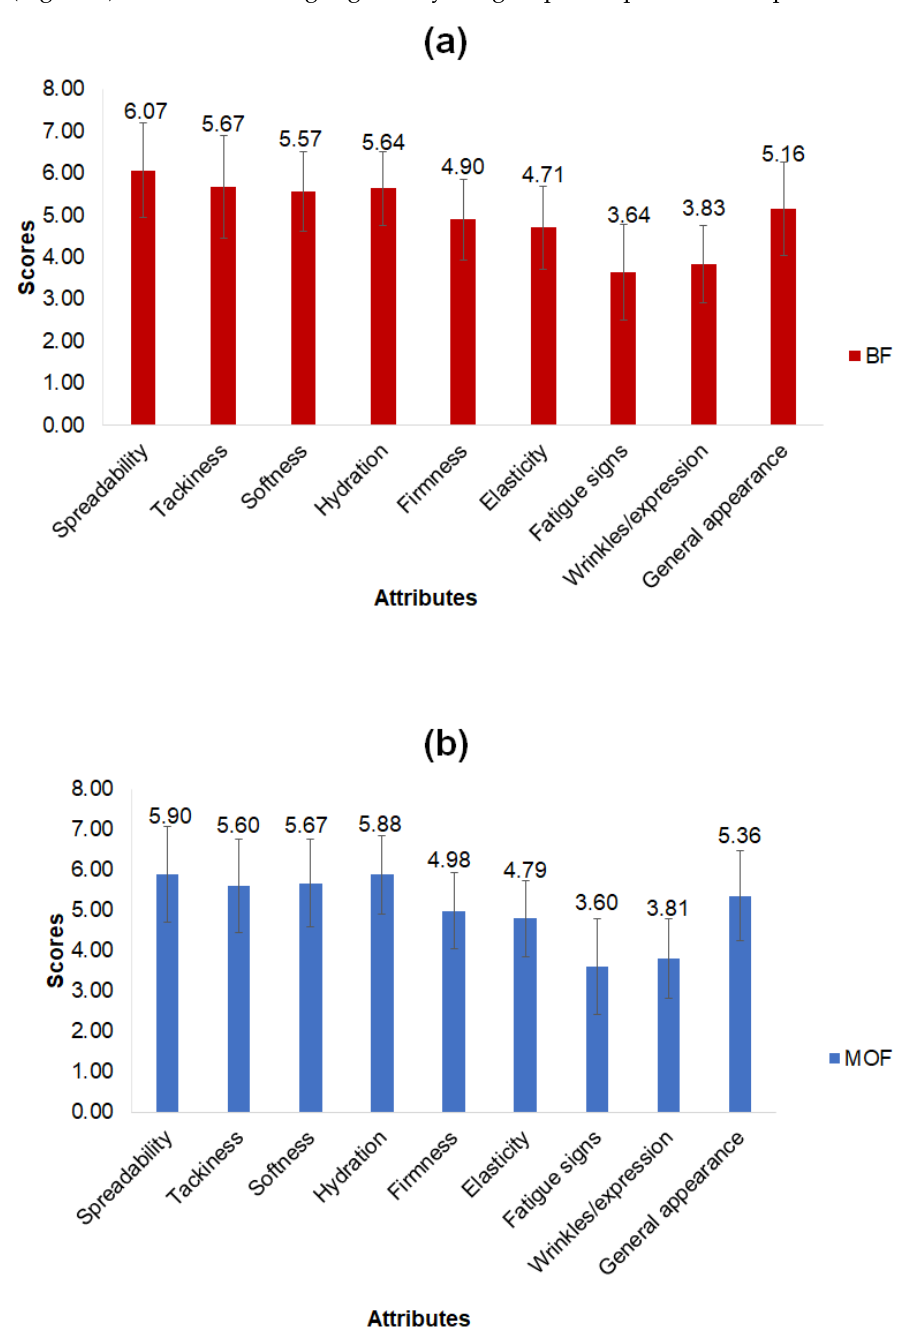
Figure 3. Results of sensory evaluation of cosmeceutical formulations: base (BF) ( a ) and with microcapsules of coffee oil (MOF) ( b ). Mean values of 58 evaluations; error bars: standard deviation; no significant difference (by t test, p > 0.05) between BF and MOF for the attributes evaluated. Average scores for the signs of fatigue and wrinkles/expression attributes (3.6 and